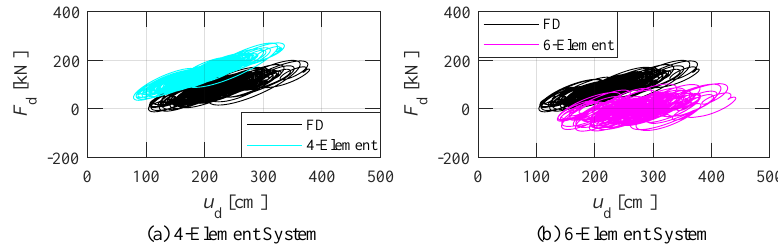
Figure 20. Comparison of hysteresis loop in the 2H-SS system